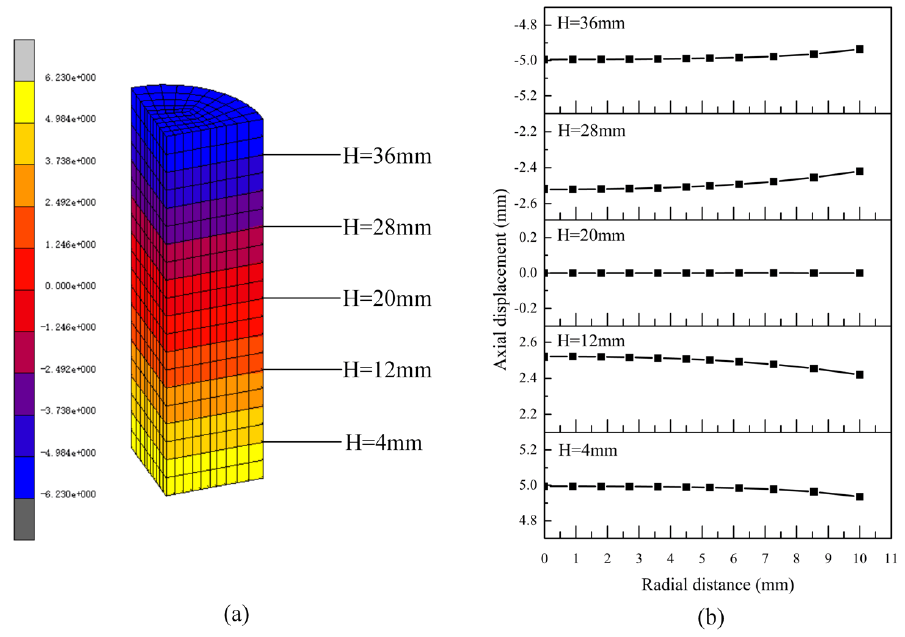
Figure 18. Equivalent von Mises stress distributions in powder compacts at different μ values of ( a ) 0.05, ( b ) 0.2, and ( c ) 0.4.